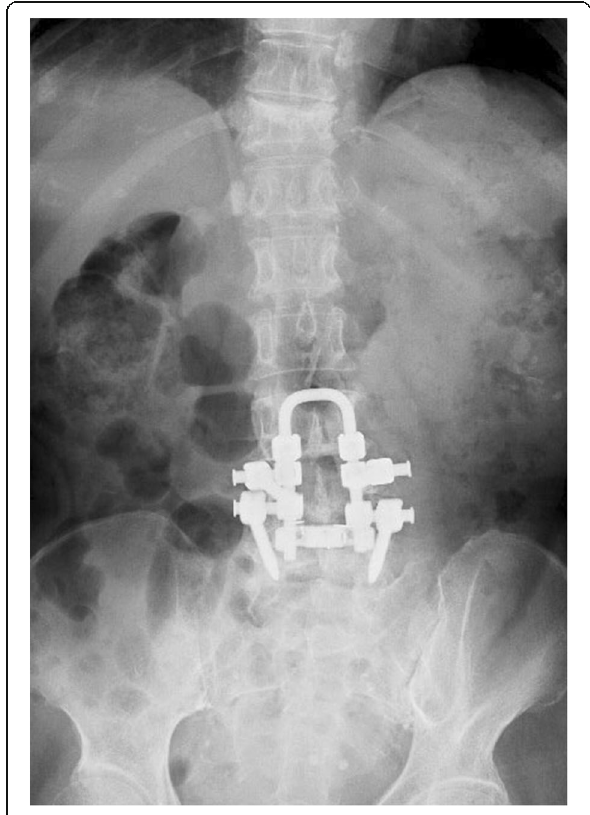
Fig. 1 Radiograph showing lumbar spinal bone after two back surgeries in an elderly woman with failed back surgery syndrome